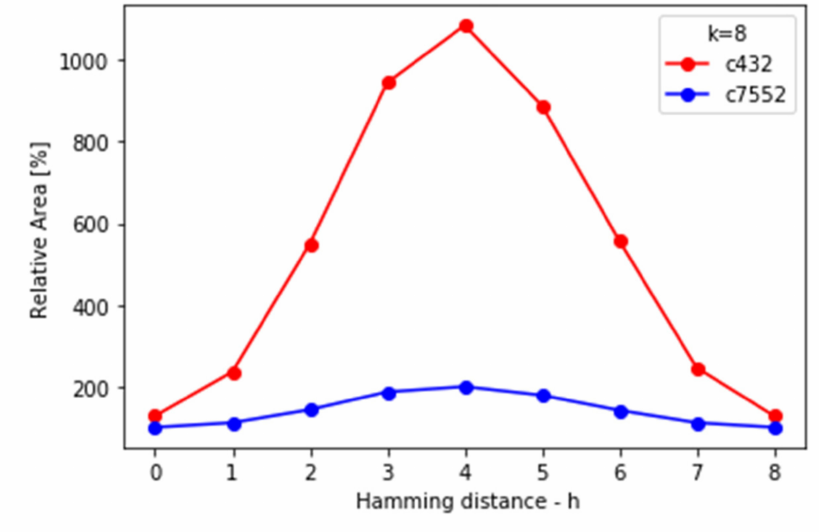
Figure 22. Relative area increase in locked netlists for different values of Hamming distance.